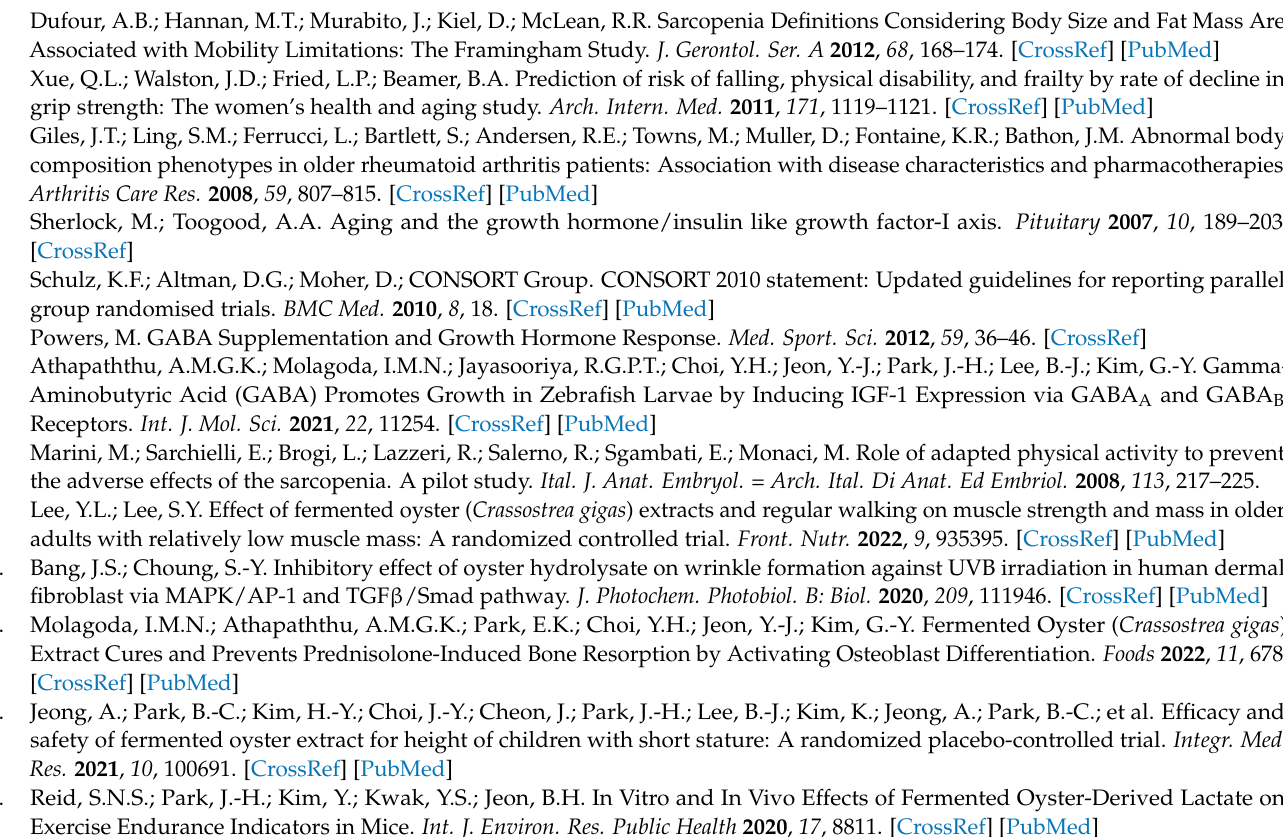
comparison of the 60 ◦ /s right knee extension peak TQ (Nm) in the ITT population. Each bar represents the mean ± SD; Figure S6: Measurement comparison of the left hand grip force (Nm) in the ITT population. Each bar represents the mean ± SD; Figure S7: Measurement comparison of the right hand grip force (Nm) in the ITT population. Each bar represents the mean ± v ; Figure S8: Measurement comparison of the IGF-1 level in the ITT population. Each bar represents the mean ± SD; Table S1: Comparison between and within each group (PP population); Table S2: Comparison between and within each group (ITT